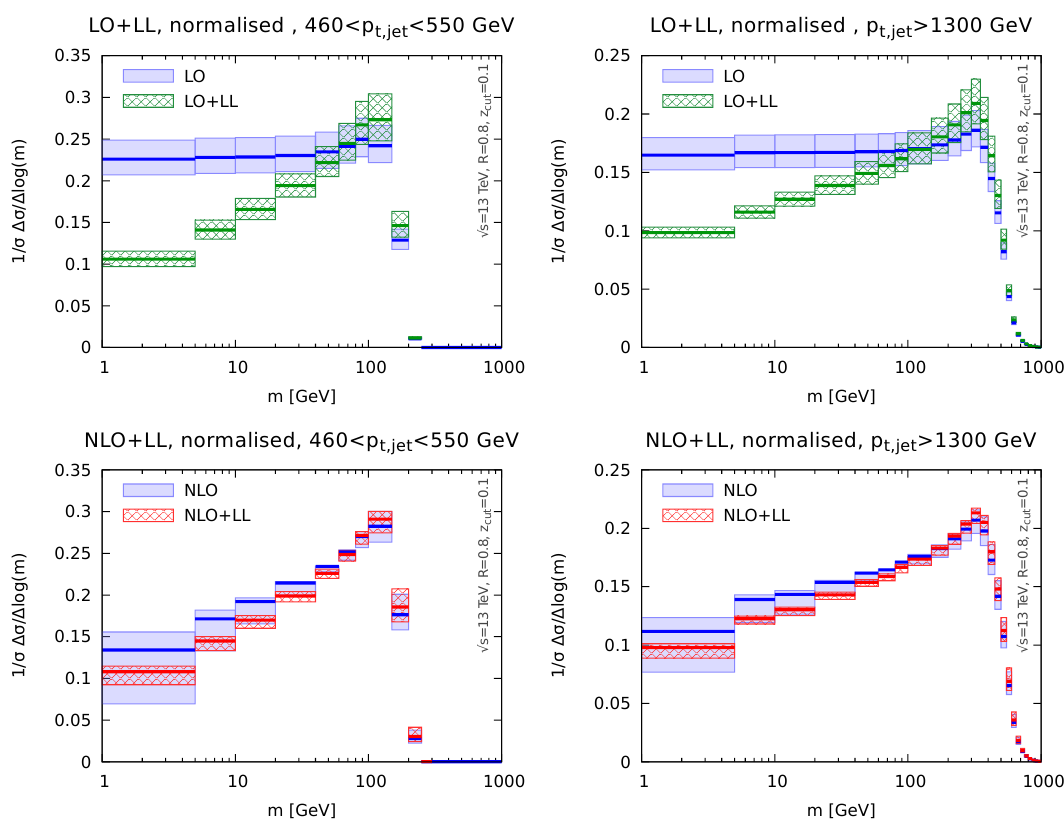
Figure 2 . Same as in (cid:12)gure 1 but for the normalised